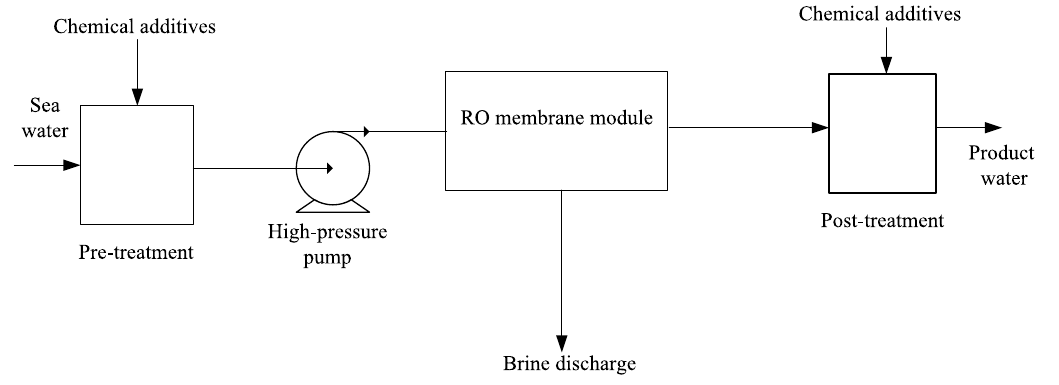
Fig. 1. RO desalination system. Figure 1. The block diagram of Doha reverse osmosis plant (DROP)